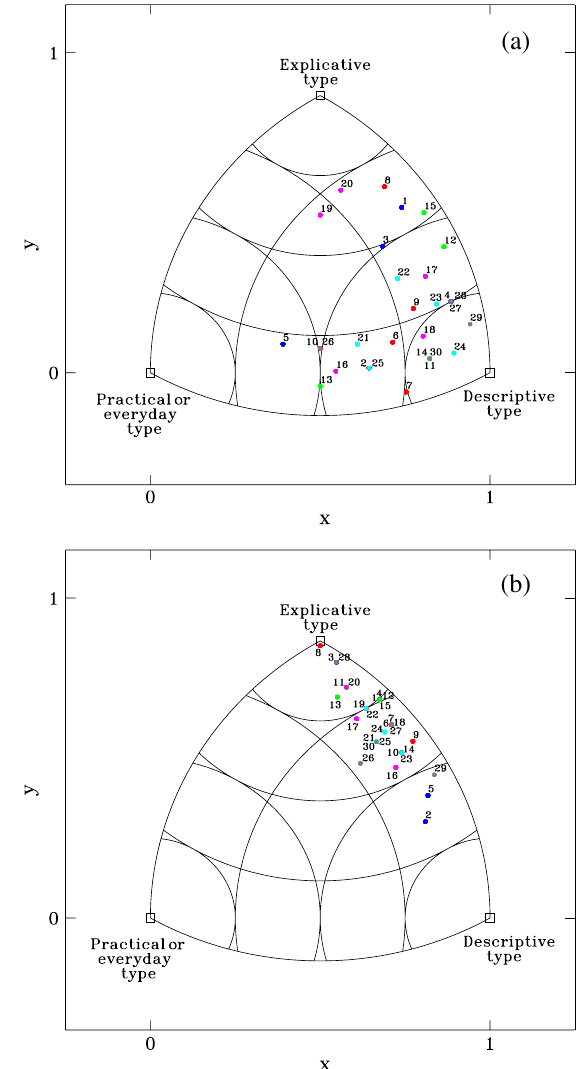
FIG. 2 (color online). Similarity graph for preinstruction (a) and postinstruction data (b). The squares indicate the vertexes of an equilateral trianglewith sidelength equalto unity andrepresent the practical or everyday, descriptiveand explicativetypologies. The x and y represent the coordinates in the similarity space. The concentric circumferences mark the distances 0.25, 0.5, 0.75, and 1 from the vertexes, the dots and numbers represent the students. Colors are used to identify students who worked within the same